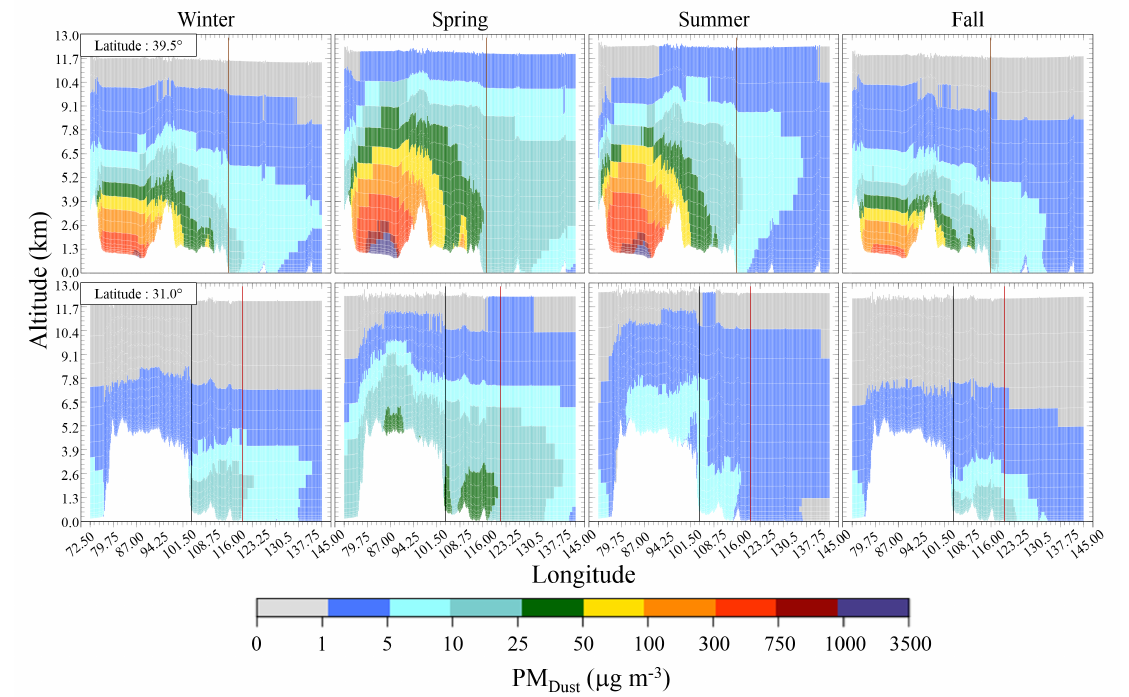
Figure 4. CHIMERE dust concentration vertical profiles longitude cut for winter (1st column), spring (2nd column), summer (3rd column) and fall (4th column). 1st row shows profiles for 39.5 ◦ latitude, 2nd row shows profiles for 31.0 ◦ latitude. Altitudes are calculated compared to sea level. All figures are produced with 2011, 2013 and 2015 data. Beijing is identified on 1st row by the brown vertical line, Chengdu is identified on 2nd row by the black vertical line and Shanghai is identified on 2nd row by the red vertical line. Transect latitudes are displayed on Figure 2. Table 3. CHIMERE Model PM 10 and PM 2.5 comparisons to hourly measurements from monitoring stations for springs 2013 and 2015. n indicates number of hourly measurements. Stations Meas